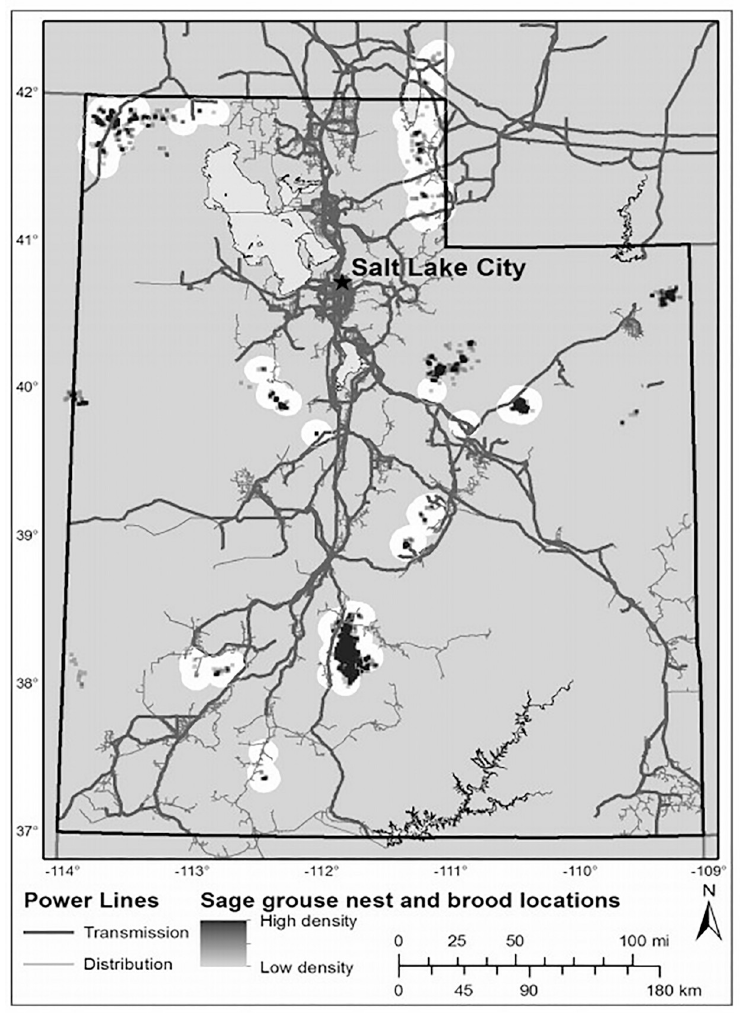
Fig 1. Electric transmission and distribution power lines relative to greater sage-grouse ( Centrocercus urophasianus ; sage-grouse) nest and brood locations in Utah, portions of southeastern Idaho, and southwestern Wyoming, USA, 1998–2013. Highlighted areas indicate sage-grouse locations within 10 km of the power lines studied.